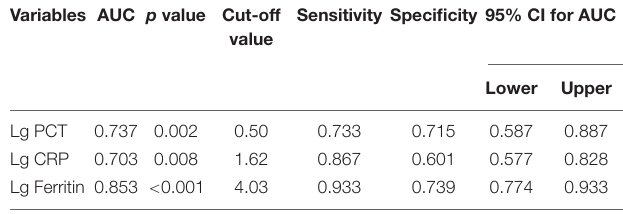
FIGURE 3 | Receiver operating characteristics curve showing the performance of serum ferritin, PCT, and CRP as predictors of mortality. The AUC of serum ferritin = 0.853, the AUC of PCT = 0.737, and the AUC of CRP = 0.703, only p Serumferritin < 0.001. TABLE 7 | Predictive values of parameters for the mortality of